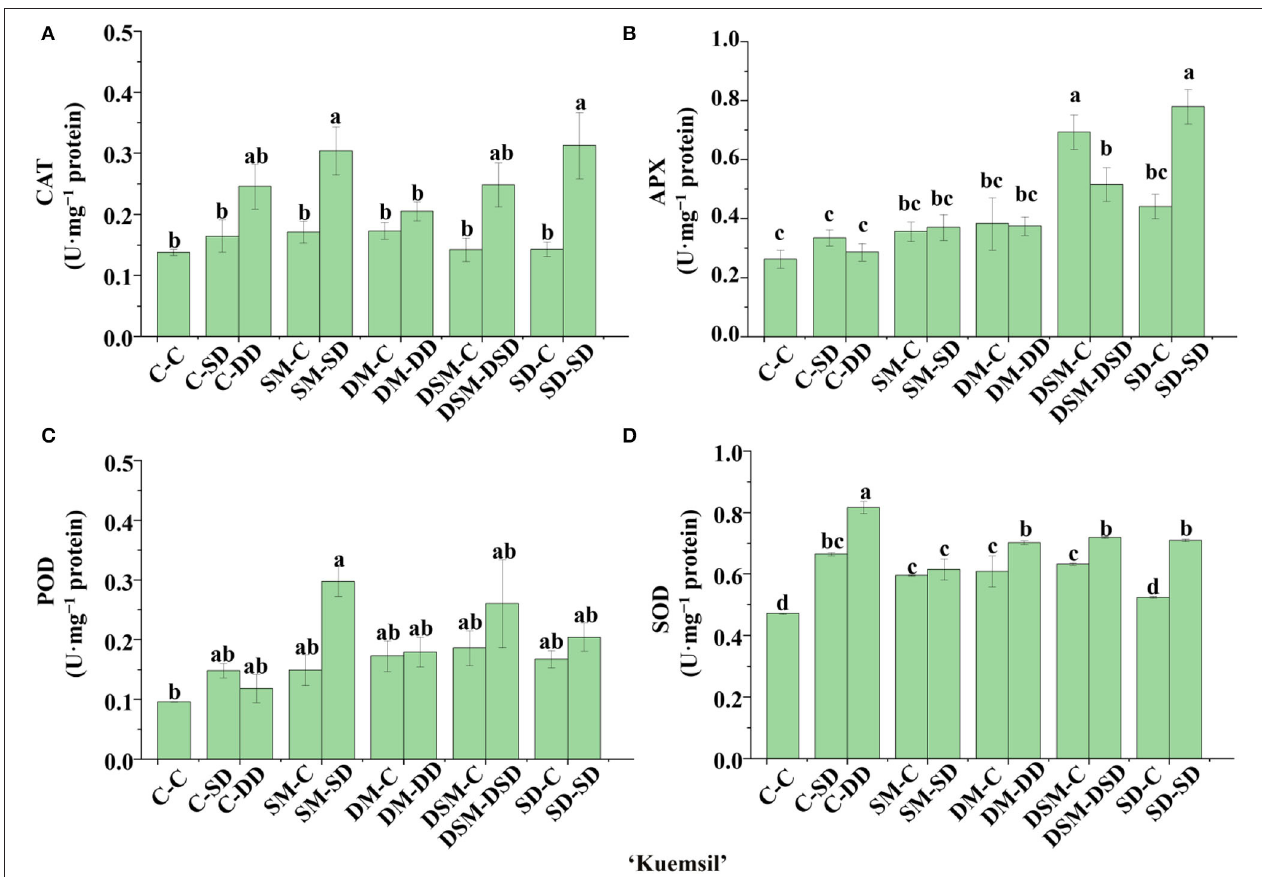
FIGURE 13 | Activities of CAT (A) , APX (B) , POD (C) , and SOD (D) in leaves of “Kuemsil” as affected by the Si treatment after subjection to 43 ◦ C for 7 days. Lowercase letters indicate significant differences calculated by the Duncan’s multiple range test at p ≤ 0.05. See Figure 1 for descriptions of treatment codes.